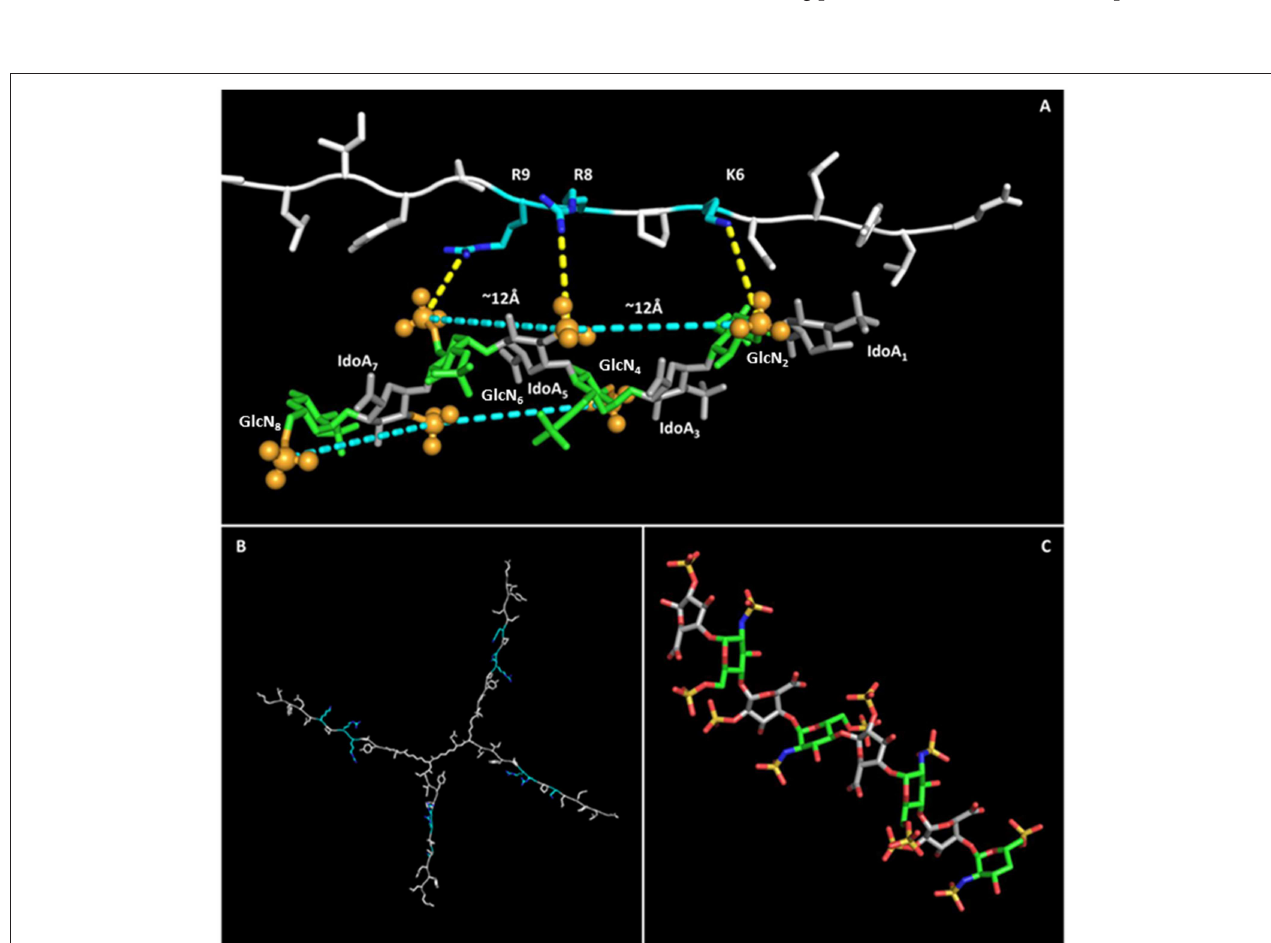
FIGURE 5 | NT4-sulfated oligosaccharide hypothetical complex. (A) Model of NT4 complexed with the 8-mer sulfated oligosaccharide. Clusters of sulfates on both sides of the helical structure of the oligosaccharide are identified by pale blue lines, with the sulfates involved represented as spheres. Polar interactions between the positive charges on peptide residues and sulfate negative clusters are drawn as dashed yellow lines. (B) Model of NT4 structure with KPRR motifs in pale blue. (C) Structure of the sulfated oligosaccharide (29).